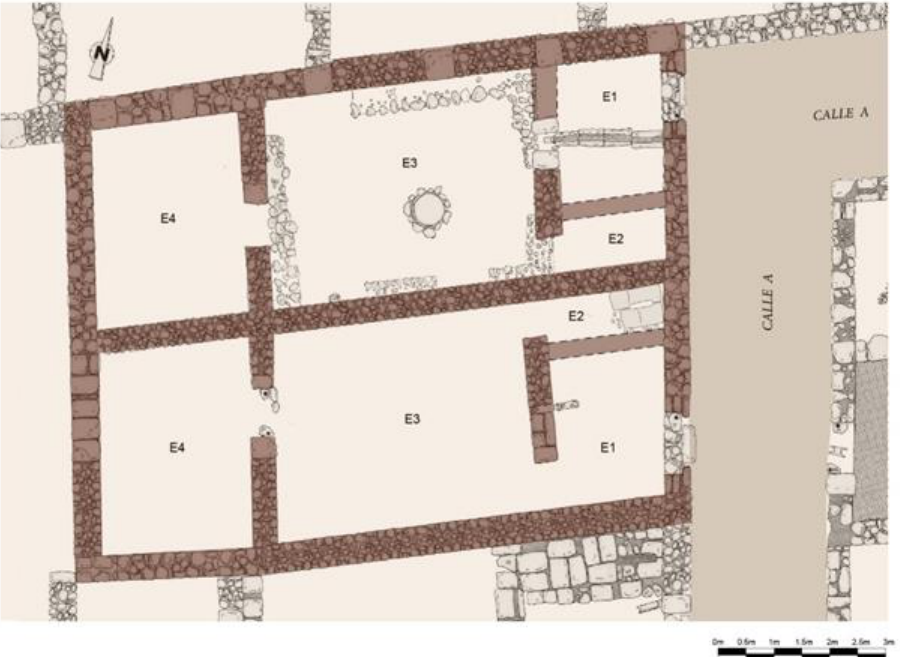
Figure 24. House 7—top—and House 8. Plan and room distribution (Aparicio Sánchez 2020, Figures 11 and 16).